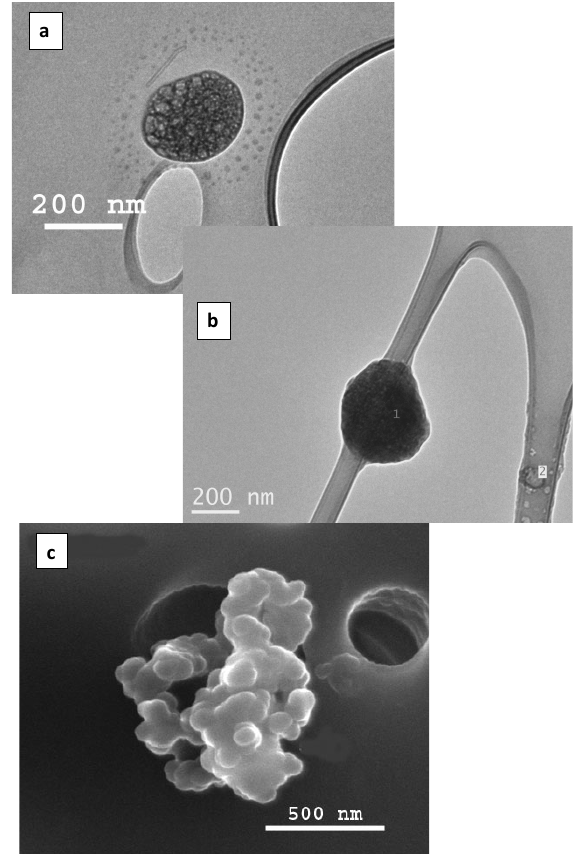
Fig. 3. Examples of particle types found when sampling from the C- 130 during VOCALS. (a) Ammonium sulfate, (b) biomass burning type, (c) soot carbon from